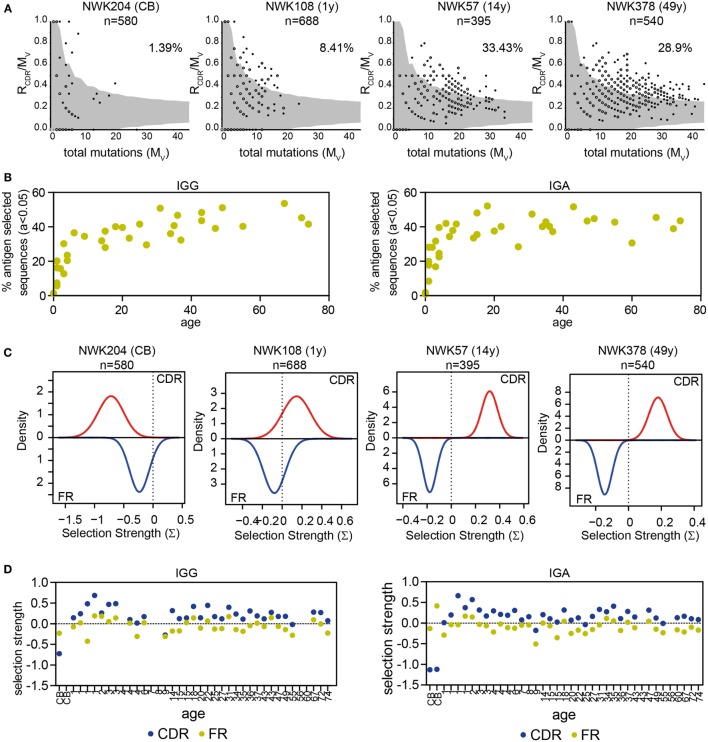
Antigen selection of IGG and IGA transcripts. (A) Graphical representation of antigen selection in IGG transcripts of four HD as analyzed using IgAT. The ratio of replacement mutations in the CDR regions (RCDR) to the total number of mutations (Mv) is plotted against the Mv. The gray area represents the 95% confidence interval for antigen selection. All sequences outside of the gray area have undergone antigen selection. The percentage of sequences that have undergone antigen selection is shown in the top right corner. Closed dots represent a single sequence, while open dots represent multiple sequences (as indicated with a number). (B) The percentage of antigen-selected transcripts (a < 0.05) as analyzed using IgAT increases in early childhood but stabilizes around 6 years of age. (C) Graphical representation of antigen selection in four HD as analyzed using BASELINe. (D) Quantification of the selection strength as analyzed by BASELINe of the CDR and FR regions in HD of different ages. No correlation is found with age.